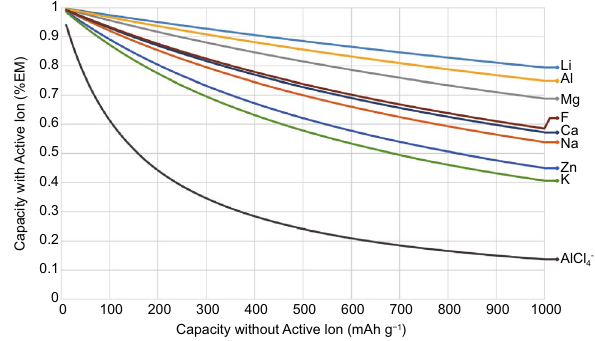
Fig. 5 Theoretical charge capacity of an electrode calculated with both ion and electrode mass, plotted as a function of the charge capacity calculated with just the electrode mass (CEM), showing the detrimental effect of high ion mass on the charge capacity of an inser- tion